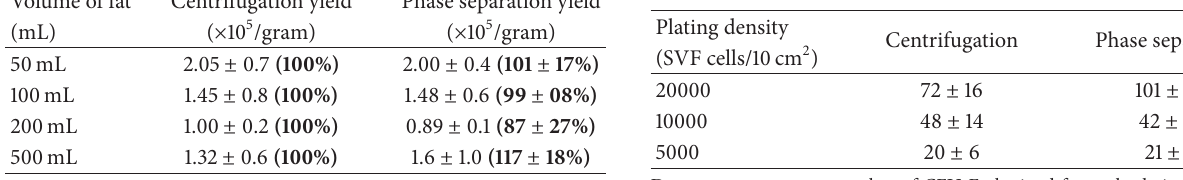
Table 3: Fibroblastic colony forming unit (CFU-F) assay for SVF recovered by aqueous phase separation as compared to whole digest